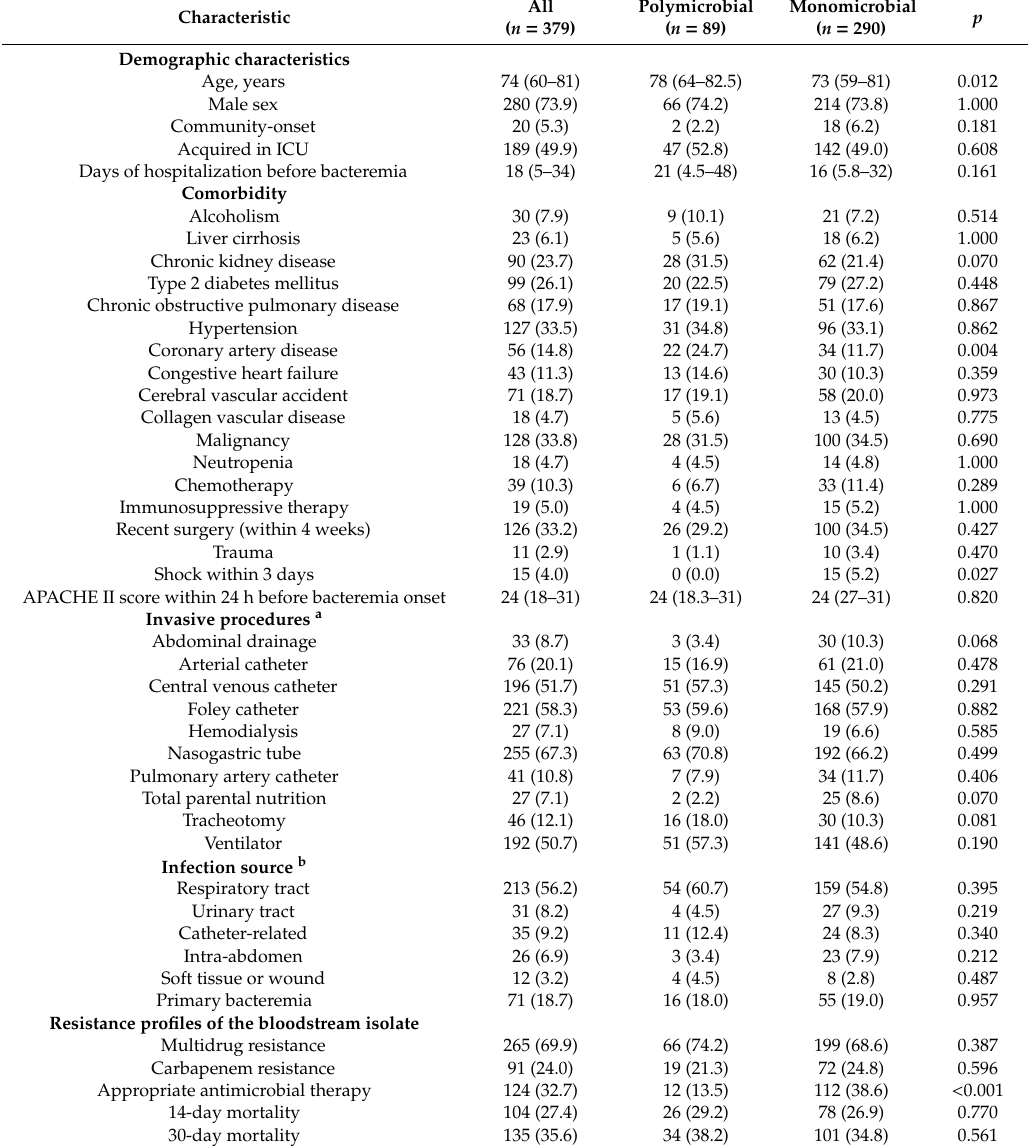
Table 1. Demographic and clinical characteristics of patients with monomicrobial and polymicrobial Acinetobacter baumannii